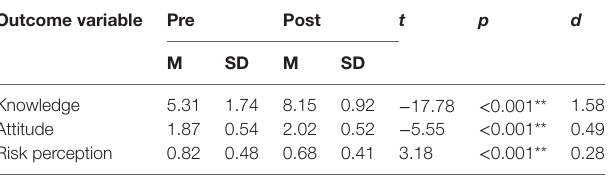
TaBle 1 | Pre- and posttest comparisons for knowledge, attitude, and risk perception. Outcome variable Pre